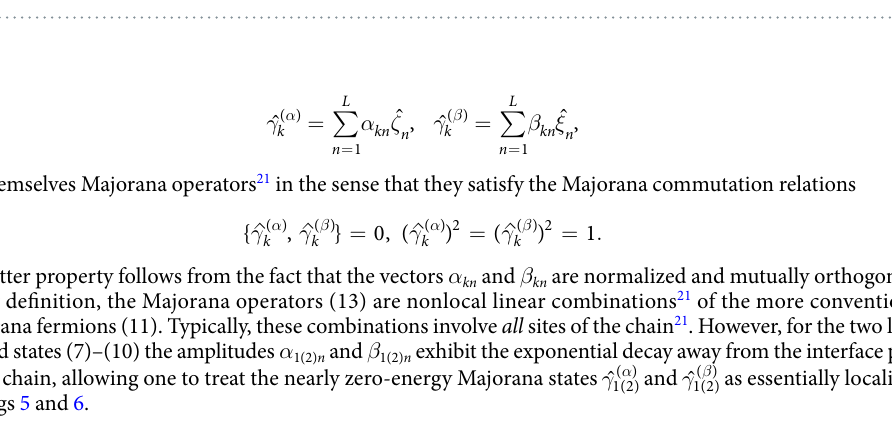
Figure 5. Majorana amplitudes of the two nearly zero-energy eigenstates of the Ising-Kitaev chain (1)–(2) with N 1 = 10, M = 20, and N 2 = 14 in the piece-wise uniform applied field (3). The red dots represent the result of the exact numerical diagonalization. The curves represent the analytic solutions. Top row: the amplitudes | α 1 n | and | α 1 n | in the strong barrier case, λ λ = = 1/2 , λ 2 = 4. The curves are given in Eqs (15) and (17). Middle row: the 1 3 amplitudes | α 1 n | and | α 1 n | in the weak barrier case, λ λ = = 1/20 , λ 2 = 4, exhibiting weak delocalization. The 1 3 curves are given in Eqs (18) and (19). Bottom row: the amplitudes | β 1 n | and | β 1 n | for λ λ = = 1/2 , λ 2 = 4. The 1 3 curves are given by either Eqs (15) and (17) or Eqs (18) and